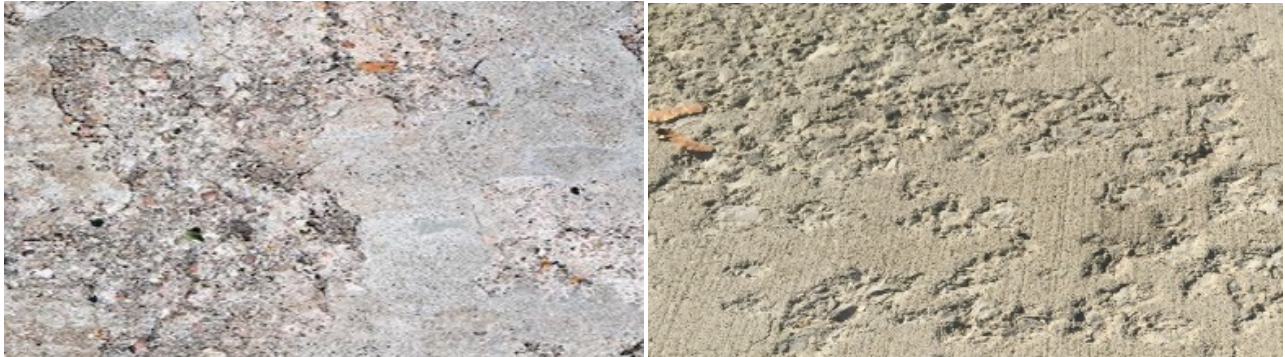
Figure 4. Sample images of concrete with spalling defects.